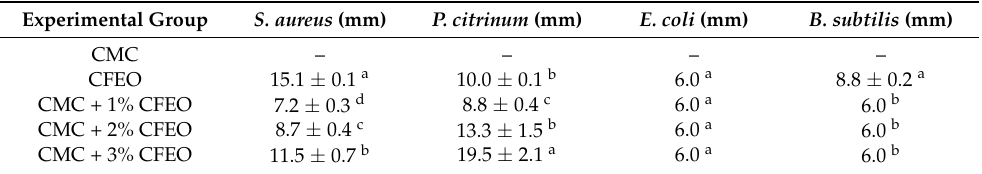
Table 5. Inhibitory zone diameters of CFEO and the CMC films incorporated with CFEO against S. aureus , E. coli , B. subtilis , and P. citrinum . Experimental Group